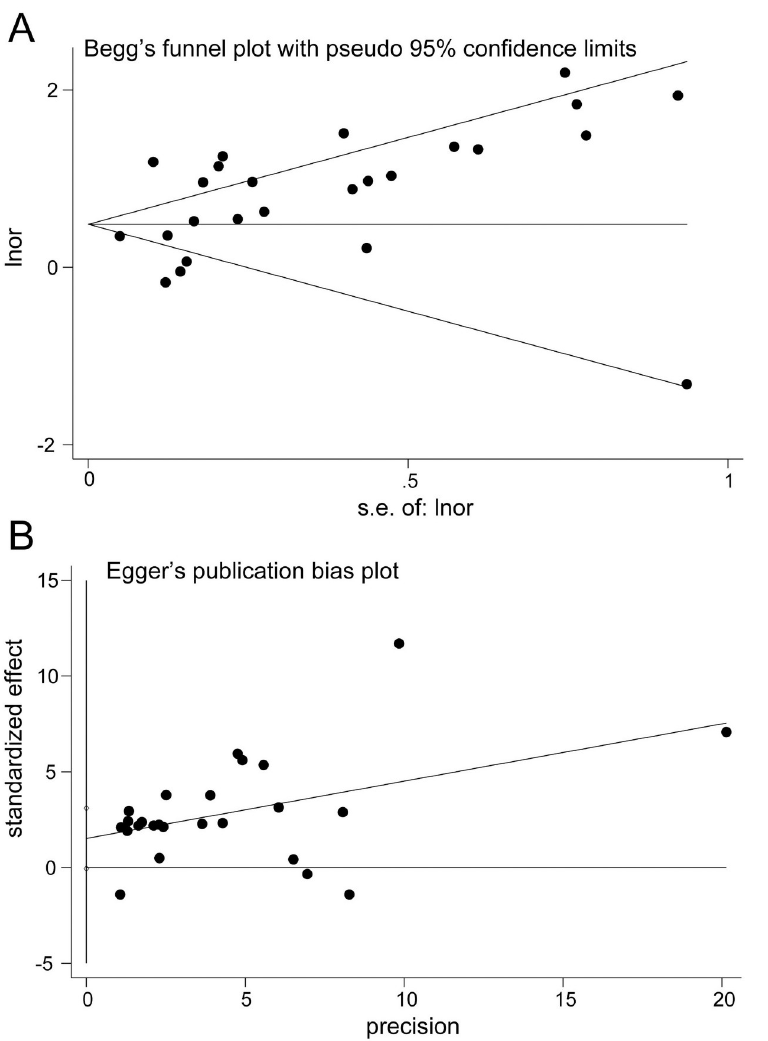
Fig 4. Publication bias plot. A, Begg’s funnel plot. B, Egger’s publication bias